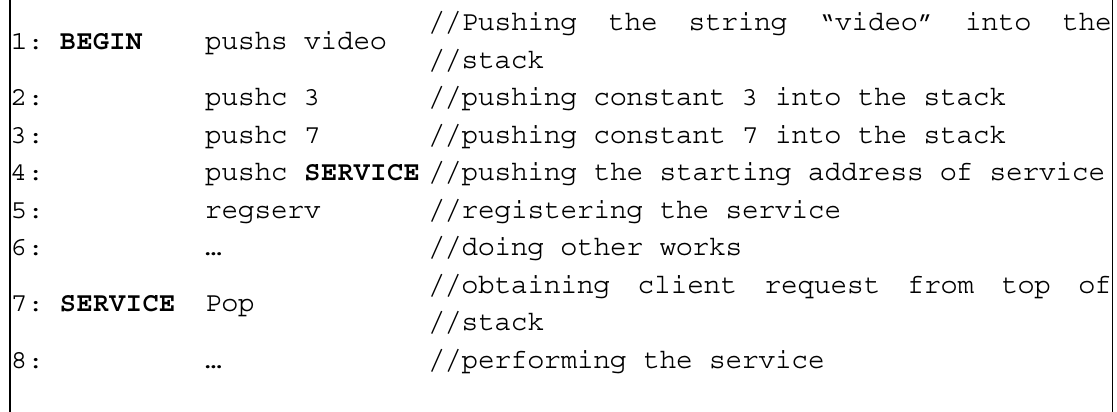
Figure 6. A sample code for registering a service in service registry using regserv